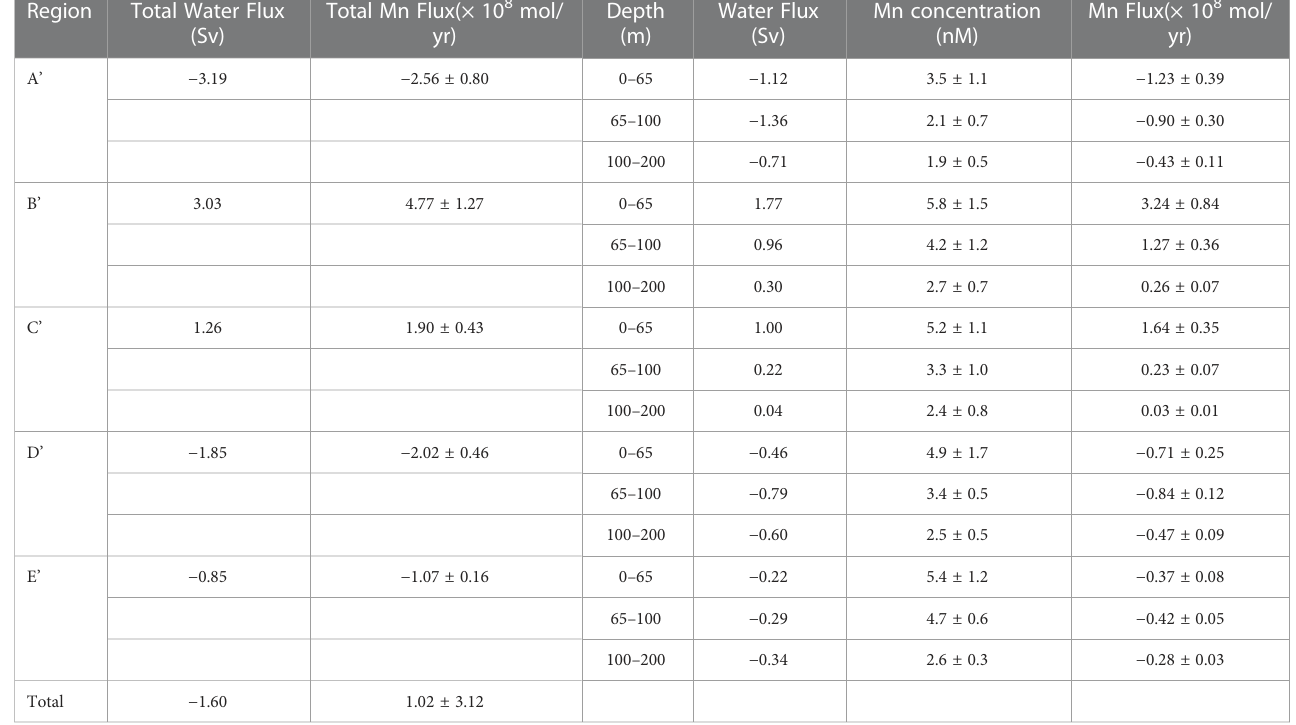
TABLE 3 Fluxes of water and dissolved Mn across the 200 – m isobath in the ECS (+: off – shelf, -: on – shelf). Region Total Water Flux Total Mn Flux(× 10 8 (Sv)